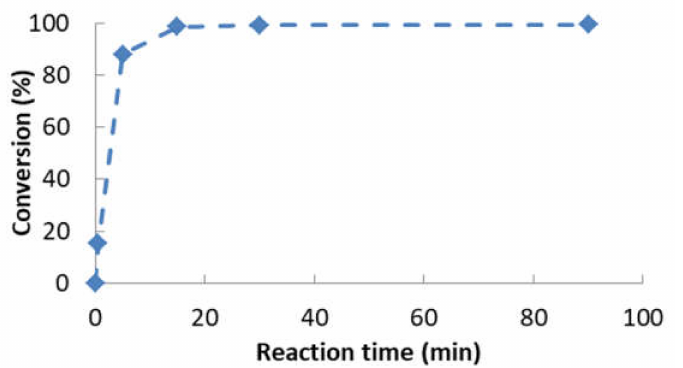
Figure 5. Conversion evolution during the second transesterification to obtain rapeseed biolubricant (FAME:alcohol ratio, 1:1; reaction temperature, 120 ◦ C; catalyst concentration, 1.5%; stirring rate, 500 rpm; reaction time, 90